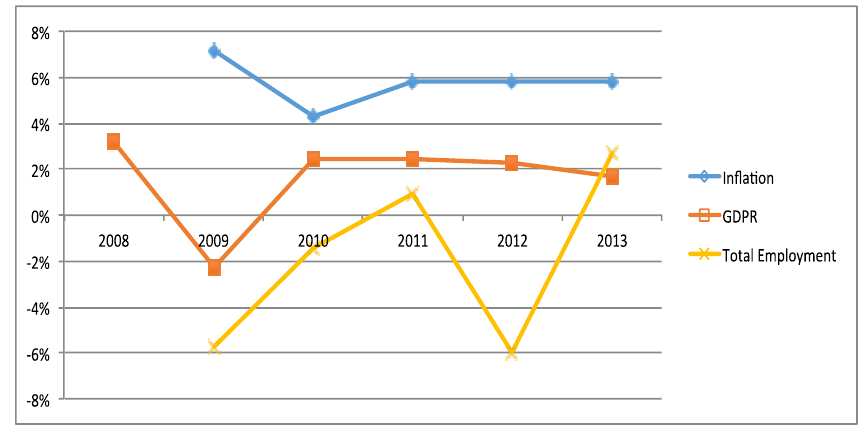
FIGURE 2: Trends in key economic variables in Free State - Post-crisis (%) Source: Statistics South Africa (2013) and IHS Global Insight